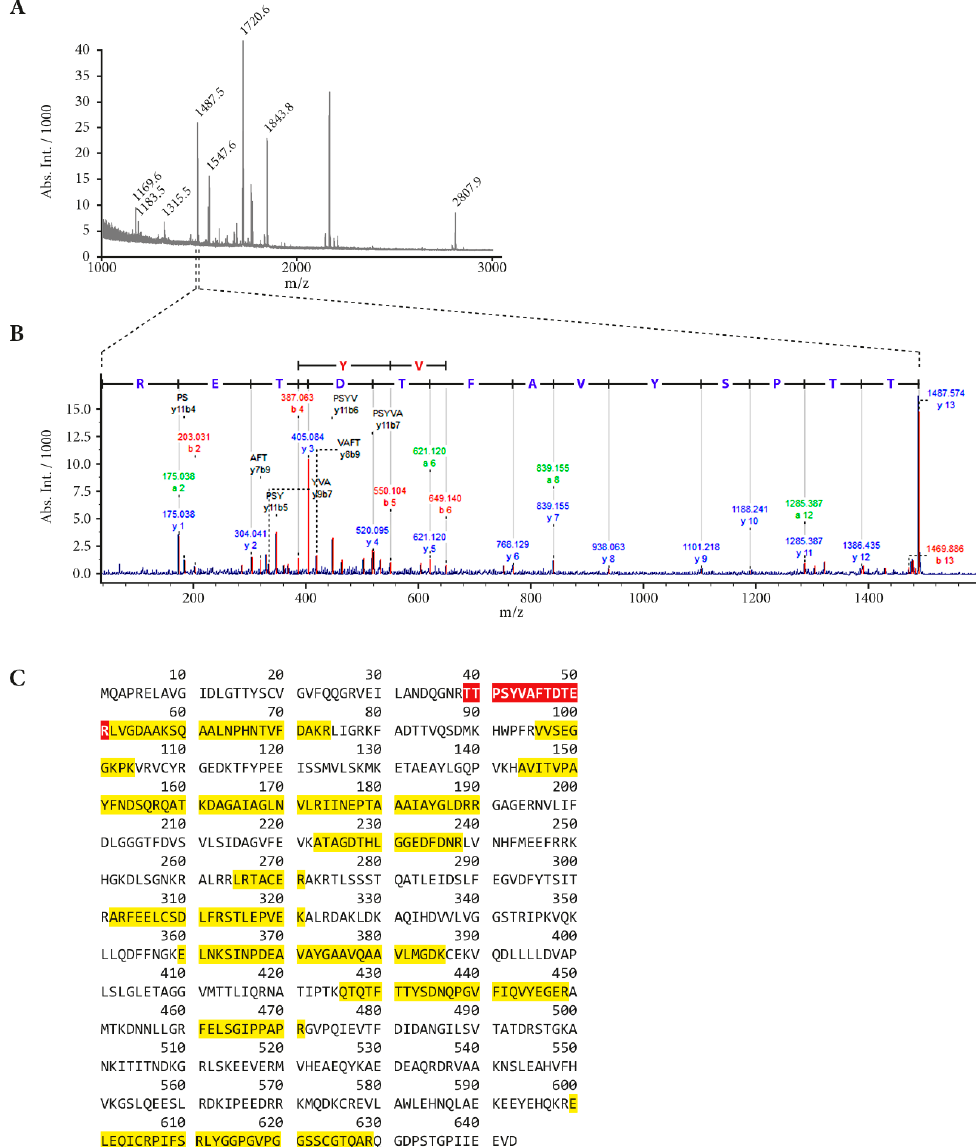
Figure 2. MALDI-TOF MS(/MS) measurements of a protein spot after tryptic cleavage identified HSP6A. ( A ) Peptide mass fingerprint of HSPA6 identified by MASCOT database matching resulted in a score of 86.6. ( B ) MS/MS spectrum of the ion at m / z 1487.5 resulted in a sequence tag of 13 amino acids. The complete series of y-ions could be found. ( C ) A sequence coverage of 35.5% was found for HSPA6 (UniProtKB-P17066). Assigned peptides are indicated with a yellow background. The sequence of the peptide subjected to MS/MS fragmentation depicted in ( B ) (amino acids 39–51) is highlighted with a red background.